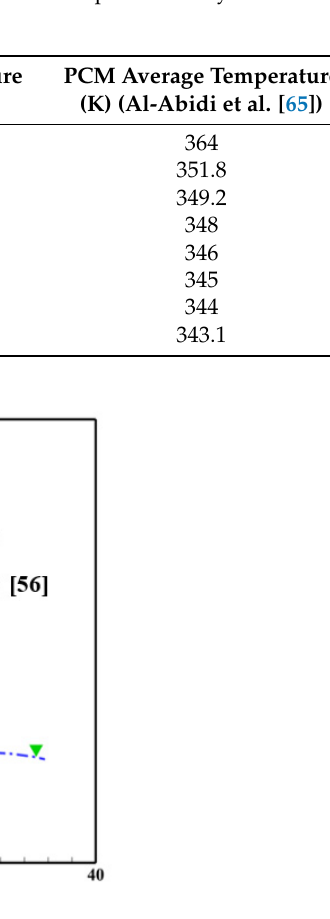
Figure 3. Code verification during the solidification process using the experimental study of Al-Abidi et al. [65] .